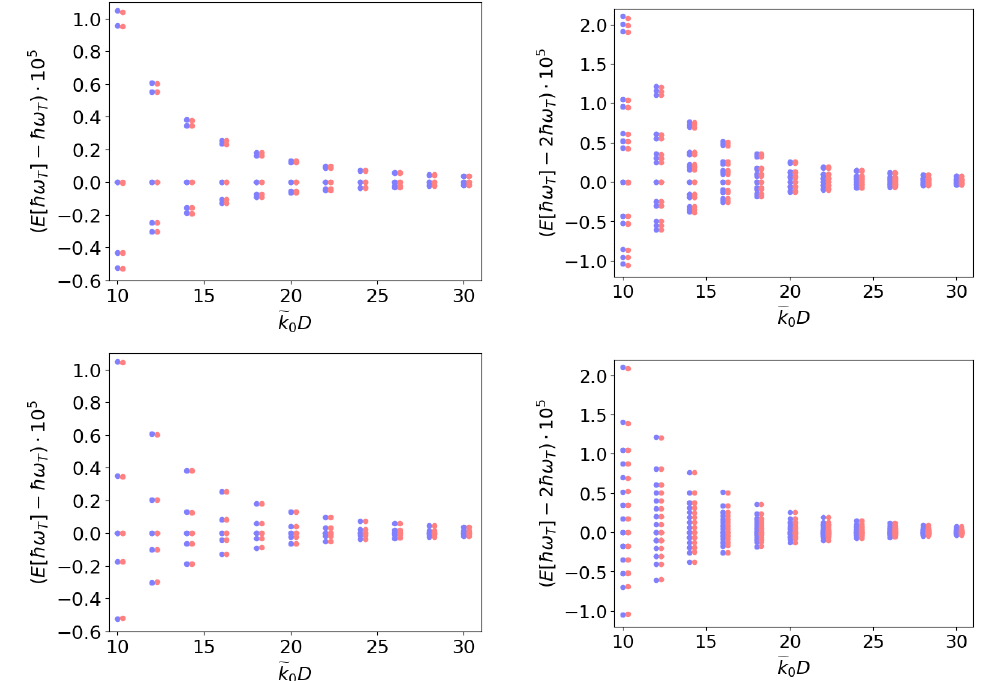
Figure 4. Eigenenergies of three harmonically trapped ions with Coulomb repulsion ordered like a triangle (blue) in comparison to particles trapped along a fiber with light-induced interaction (red), as shown in Figure 3, as a function of the distance between the interacting ions. This can be achieved by finding the right distances, frequencies and interaction strengths to solve Equation (19). In the simulation, the particles are trapped along the fiber at fixed distances d 12 = d 23 = 1/3 λ 0 , d 34 = λ 0 and d 45 = d 56 = 1/4 λ 0 and the pump laser parameters are adjusted to mimic Coulomb interactions at arbitrary distances between the ions with ∆ k = 0.33 k 0 . (cid:101) k 0 and (cid:101) Ω / ω T are defined as in Figure 2. The figures in the upper row show the eigenenergies when all particles are interacting, while in the lower figures the interaction between ion numbers 1 and 3 at the bottom of the triangle is